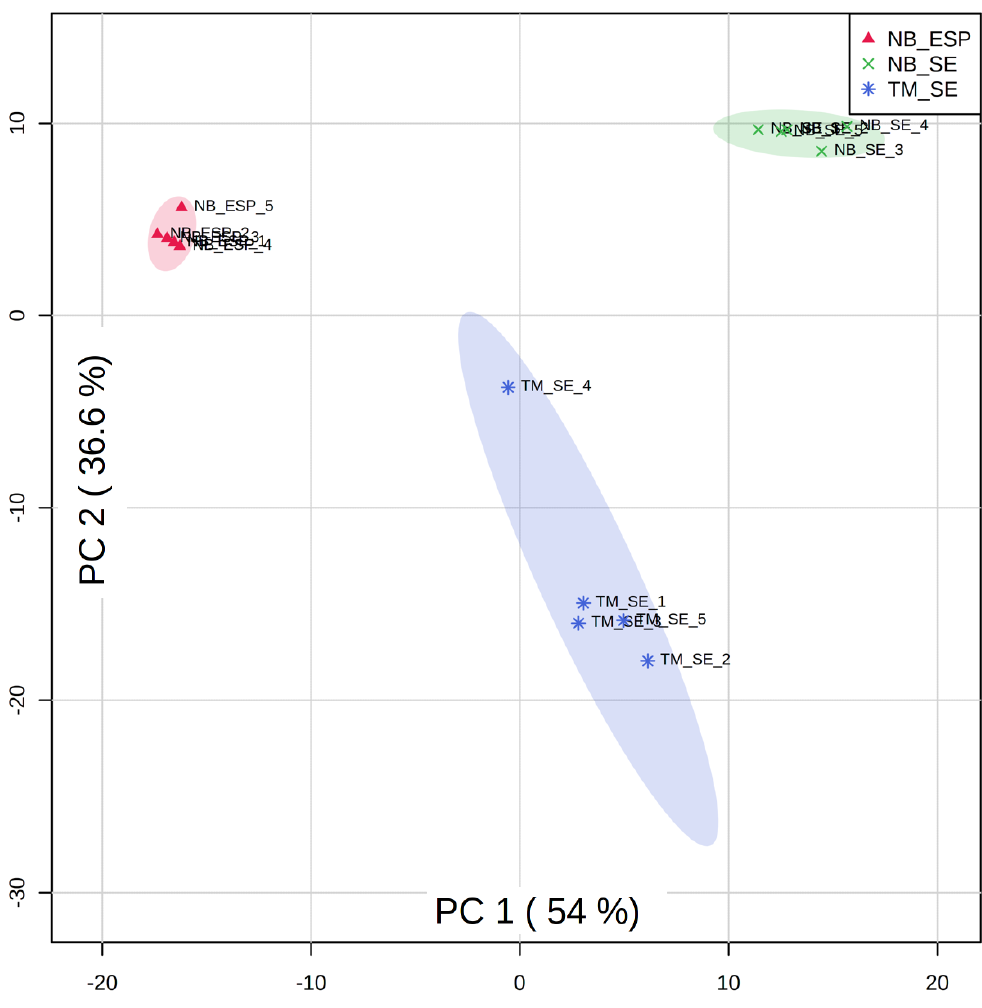
Figure 8. Principal component analysis scores plot comparing LC-MS metabolomic profiles for the lipids among three sample groups: the somatic extract of infective third-stage larvae (L3) of N. brasiliensis (NB_SE) (green), the excretory / secretory products of N. brasiliensis L3 (NB_ESP) (red), and the somatic extract of T. muris embryonated eggs (TM_SE) (blue) with five replicates each. The amount of variance explained is shown in parentheses on each axis. Media (QC_Media) and pooled quality control (QC_P) values were excluded from the analysis, as they were subtracted from the samples.